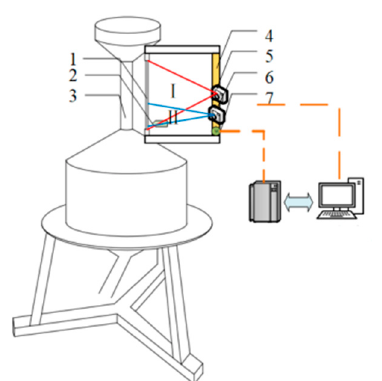
Figure 3. A diagram of the proposed automated acquisition system for liquid level measurements.